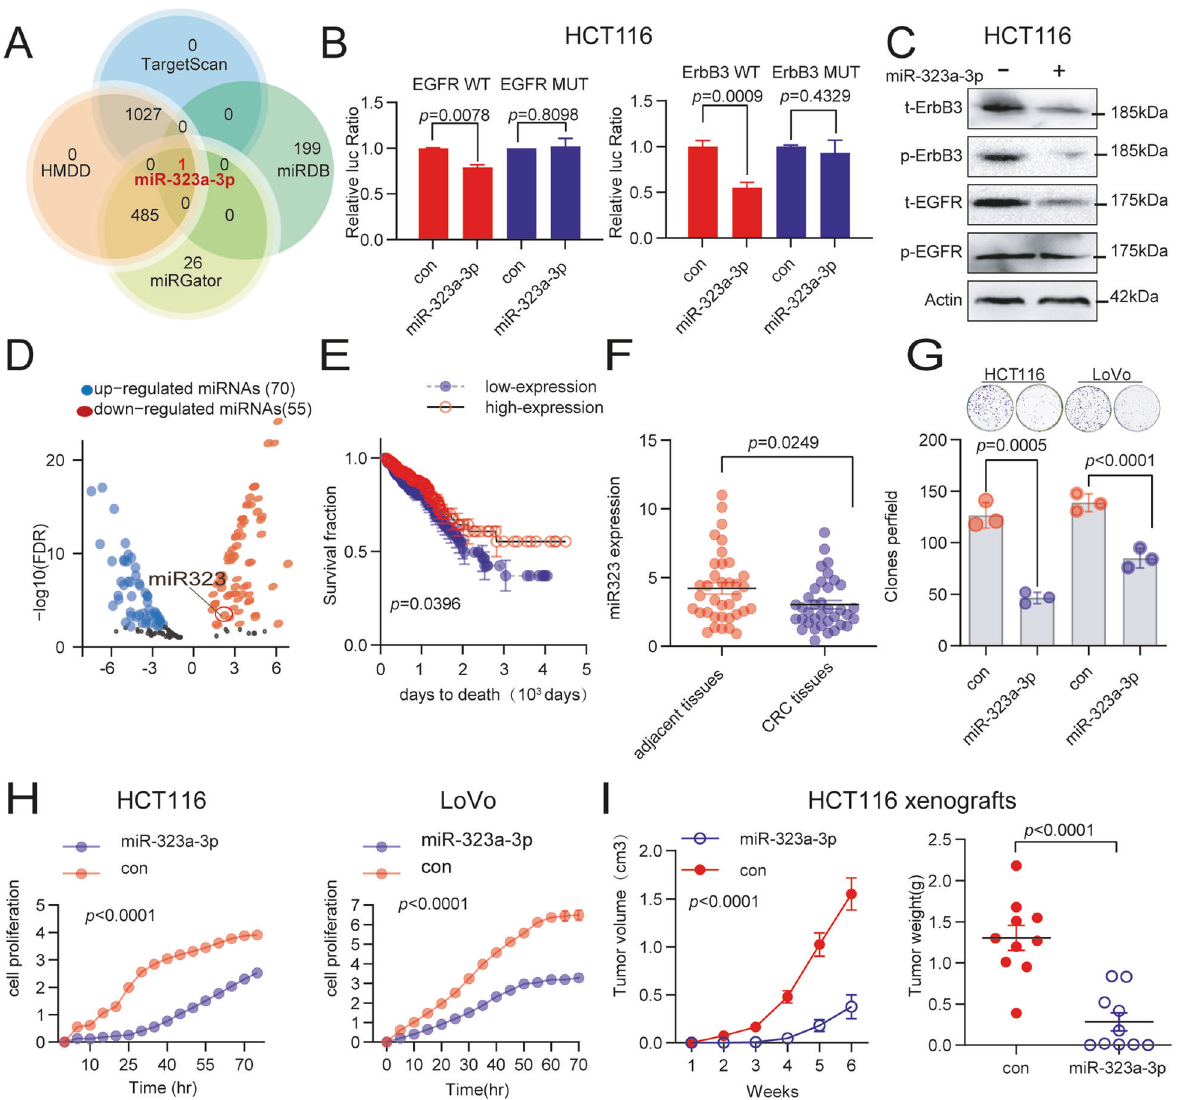
Fig. 2 MiR-323a-3p targets ErbB3/EGFR and inhibits CRC cell growth. A MiR-323-3p was a candidate microRNA co-targeting ErbB3/EGFR, found in all four microRNA target prediction databases (miRdb, targetScan, HMDD, and miRGator). B miR-323-3p inhibited the luciferase activity of the wild type ErbB3/EGFR 3 ’ -UTR contained construct, while did not inhibit the luciferase activity of the mutant ErbB3/EGFR 3 ’ -UTR contained construct. C MiR-323a-3p inhibited total and phosphorylated ErbB3/EGFR levels in HCT-116 cells. D The expression of miR-323a-3p was signi fi cantly downregulated in CRC tissues compared to its normal control (TCGA data). E The CRC patients with low miR-323a-3p expression were associated with poor prognosis (TCGA data). F Low miR-323a-3p expression was validated in CRC tissues by qRT-PCR assay in CRC tissues (compared to adjacent tissues, n = 36). G MiR-323a-3p inhibits the clone formation ability in HCT-116 and LoVo cells. H MiR-323a- 3p inhibits cell growth in HCT-116 and LoVo cells. I MiR-323a-3p over-expression inhibits tumor growth in a subcutaneous tumor model (HCT- 116 cells, n = 6 each